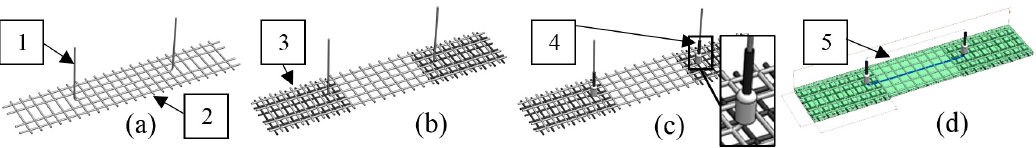
Figure 1. The steps of making a multifunctional composite specimen: ( a ) The selected fibre bundle (1) pulled out of the fabric (2) at both ends; ( b ) laying the second layer of reinforcement (3) on both sides; ( c ) putting the ends of the selected fibre bundle in cord-end terminals (4); and ( d ) the specimen soaked with resin (5).